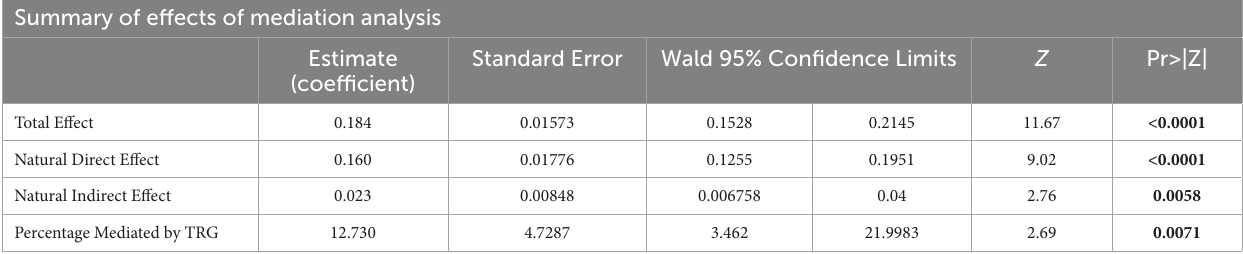
TABLE 3 Summary of coefficient of mediation analysis among PTSD severity, trauma related guilt, and suicide ideation.